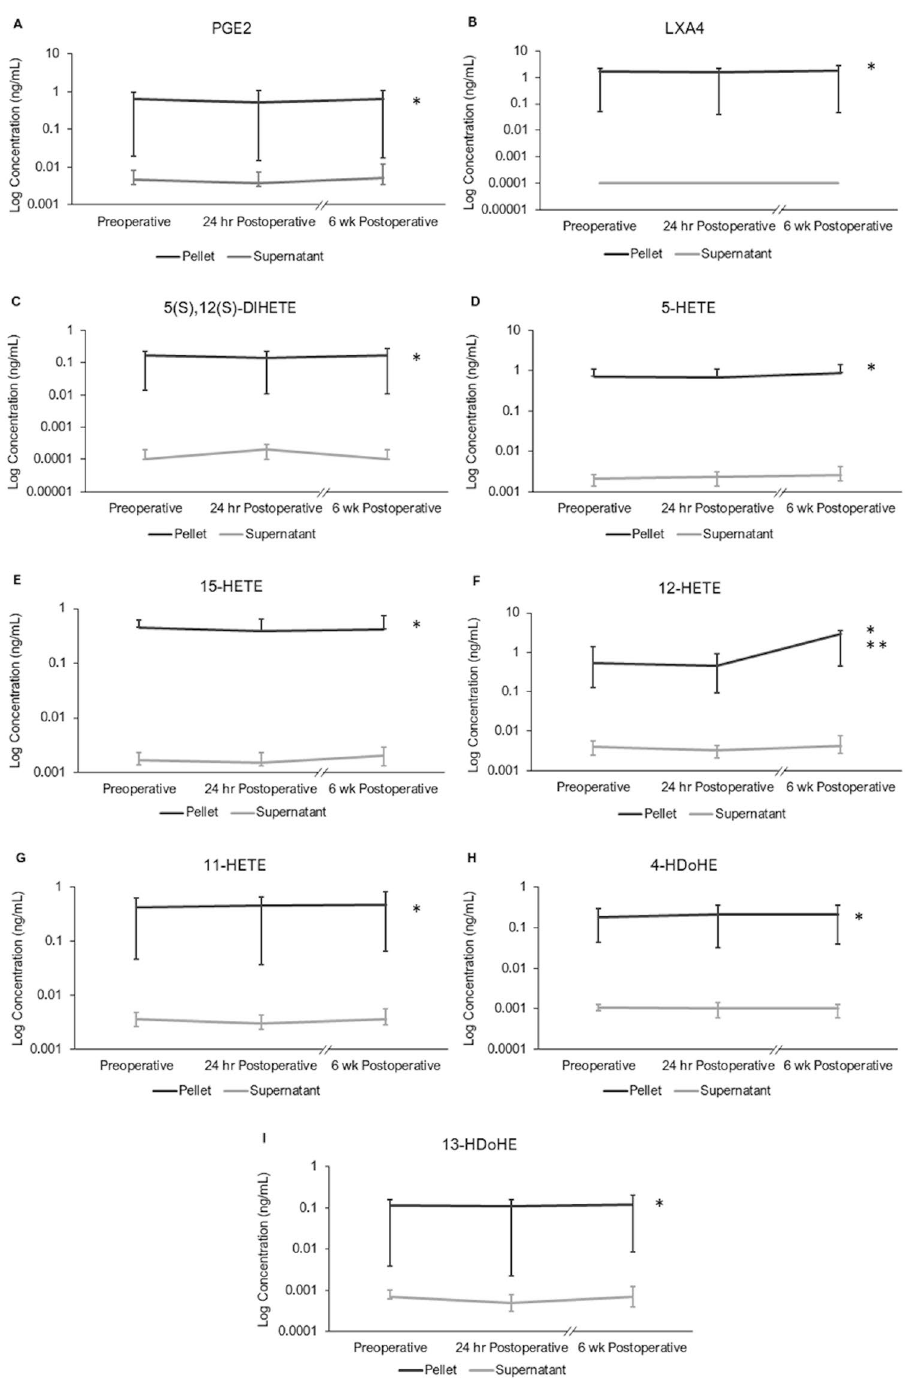
Figure 1. Centrifuged CSF Pellet and Supernatant median log concentrations of lipid mediators over time (N = 20). As supernatant analyte concentrations tended to be lower than pellet analyte concentrations by a few orders of magnitude, a log scale was used to present both sample types. *Indicates a significant ( p < 0.05) effect of sample type on analyte concentration. **Indicates a significant ( p < 0.05) effect of both time, and time by sample type interaction for analyte concentration. ( A ) PGE2. ( B ) LXA4. ( C ) 5(S),12(S)-DiHETE. ( D ) 5-HETE. ( E ) 15-HETE. ( F ) 12-HETE. ( G ) 11-HETE. ( H ) 4-HDoHE. ( I )